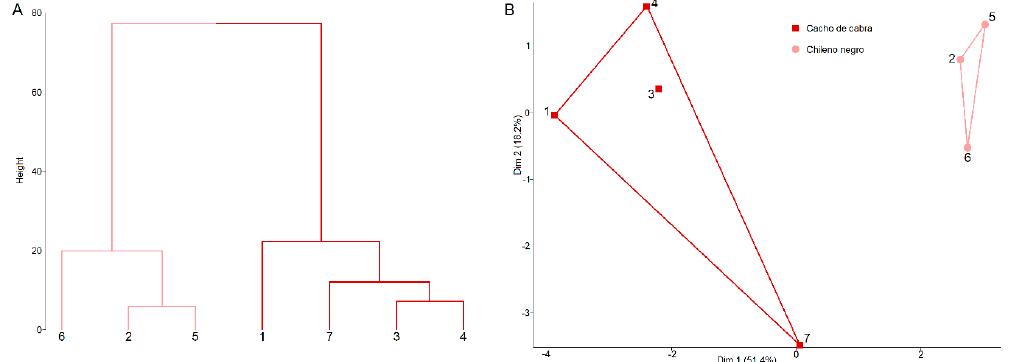
Figure 8. Cluster analysis for field data using morphological and color parameters. ( A ) Dendrogram and ( B ) partition plot generated by principal component analysis. Fields with the same landrace are grouped distinctly.